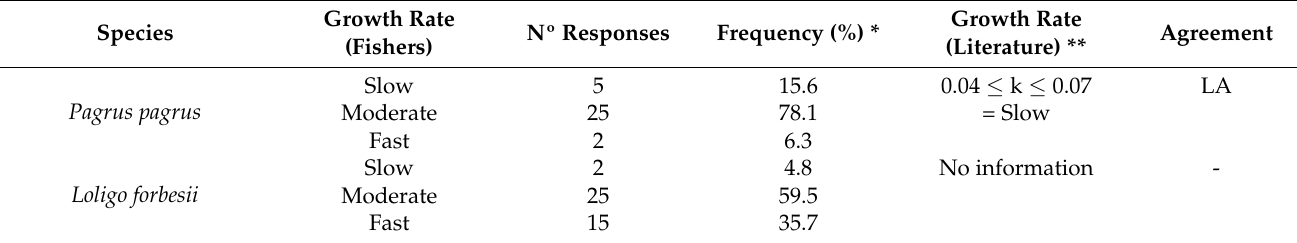
Table 2. Growth rate of the six species studied in the Azores according to fishers’ experiential knowledge, obtained from scientific literature [32], and the agreement between these two sources of information. k = von Bertalanffy growth coefficient, expressing the rate (year − 1 ) at which the asymptotic length (i.e., the length that the individual would reach if it grew indefinitely) is approached; LA = low agreement; MA = medium agreement. Nº responses = number of fishers who answered this